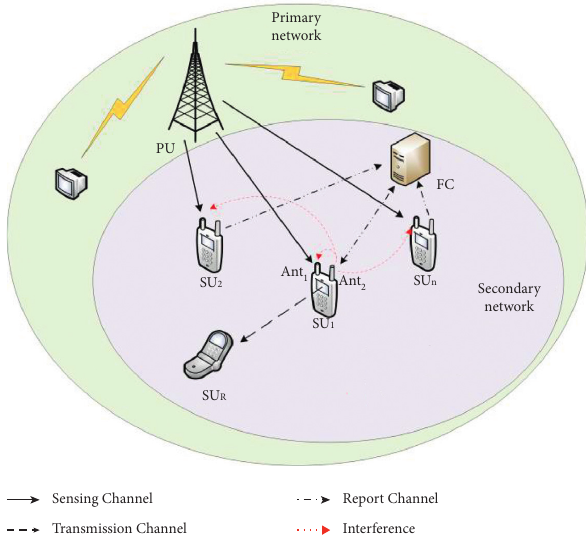
Figure 1: Full-duplex cognitive radio with cooperative spectrum